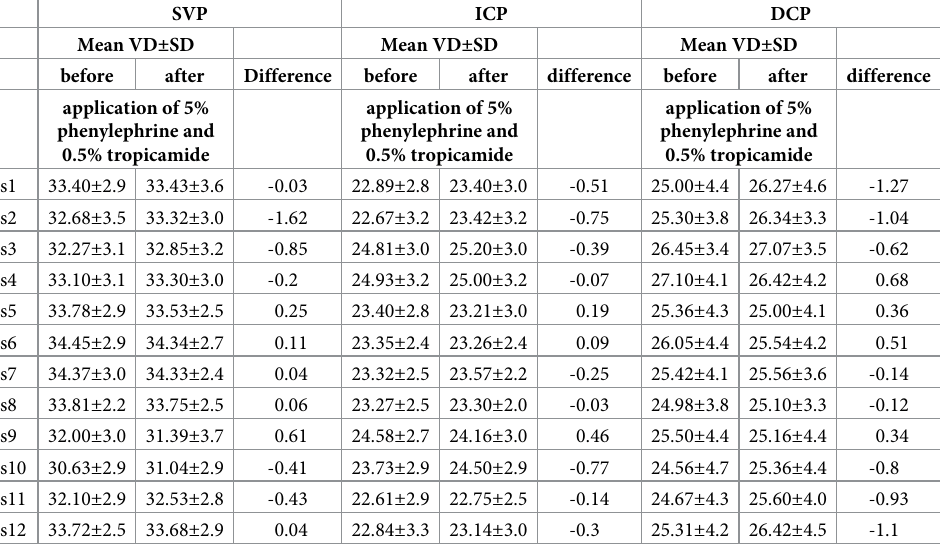
Table 1. Mean vessel density (VD), standard deviation (SD) and difference of VD before and after application of 5% phenylephrine and 0.5% tropicamide in superficial vascular plexus (SVP), intermediate capillary plexus (ICP), and deep capillary plexus (DCP) considering all 12